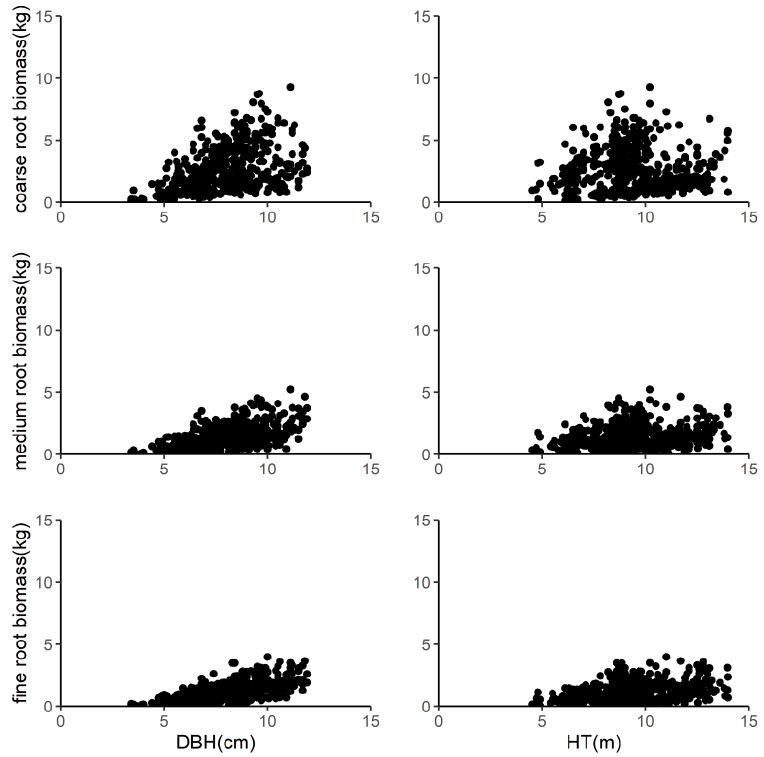
Figure 1. Relationship between the coarse roots, medium roots, and fine roots of the sampled trees and tree diameter at breast height (DBH) and height